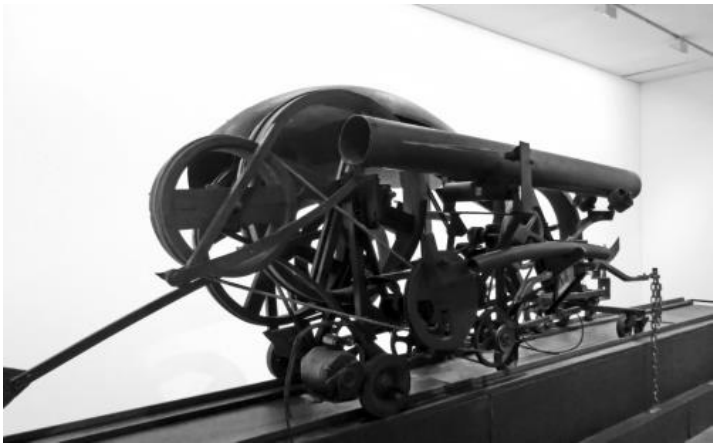
Figure 6. Hannibal II , by Jean Tinguely, 1967. Steel, motor, pulleys, black